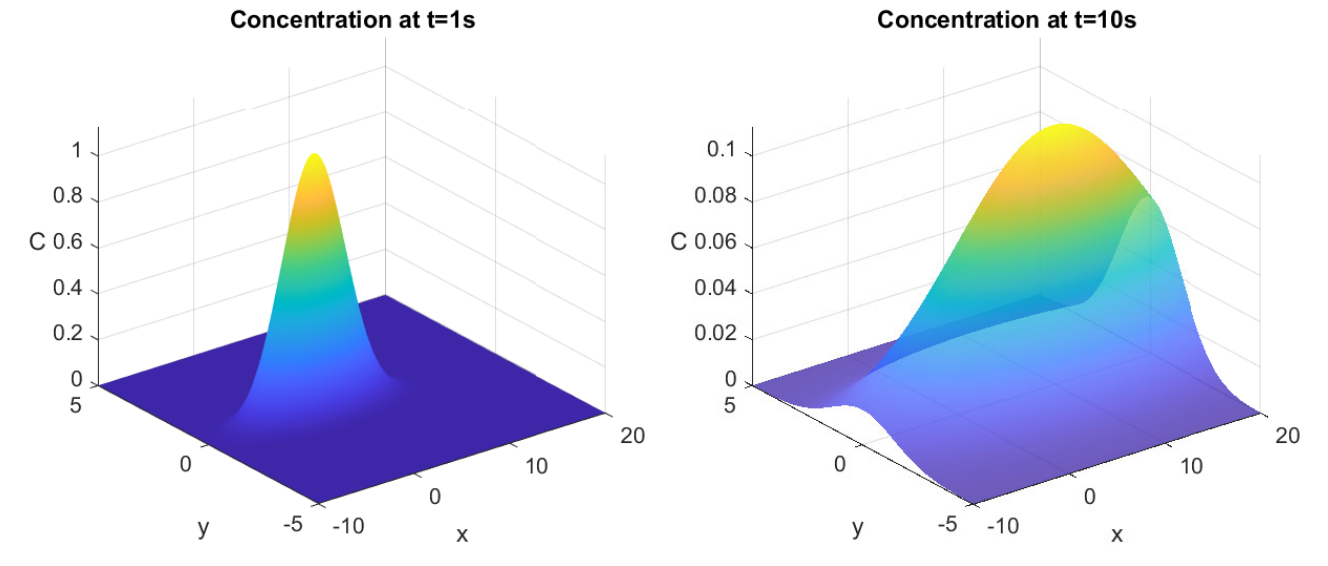
Figure 5. Concentration at t = 1 s ( left ) and t = 10 s ( right ) for problem (36), (37). The boundary conditions at x = − 10 and x = 20 are given in Figure 6. The boundary conditions for y = ± 5 are almost zero for all t ≤ 10 and are not interesting to plot.